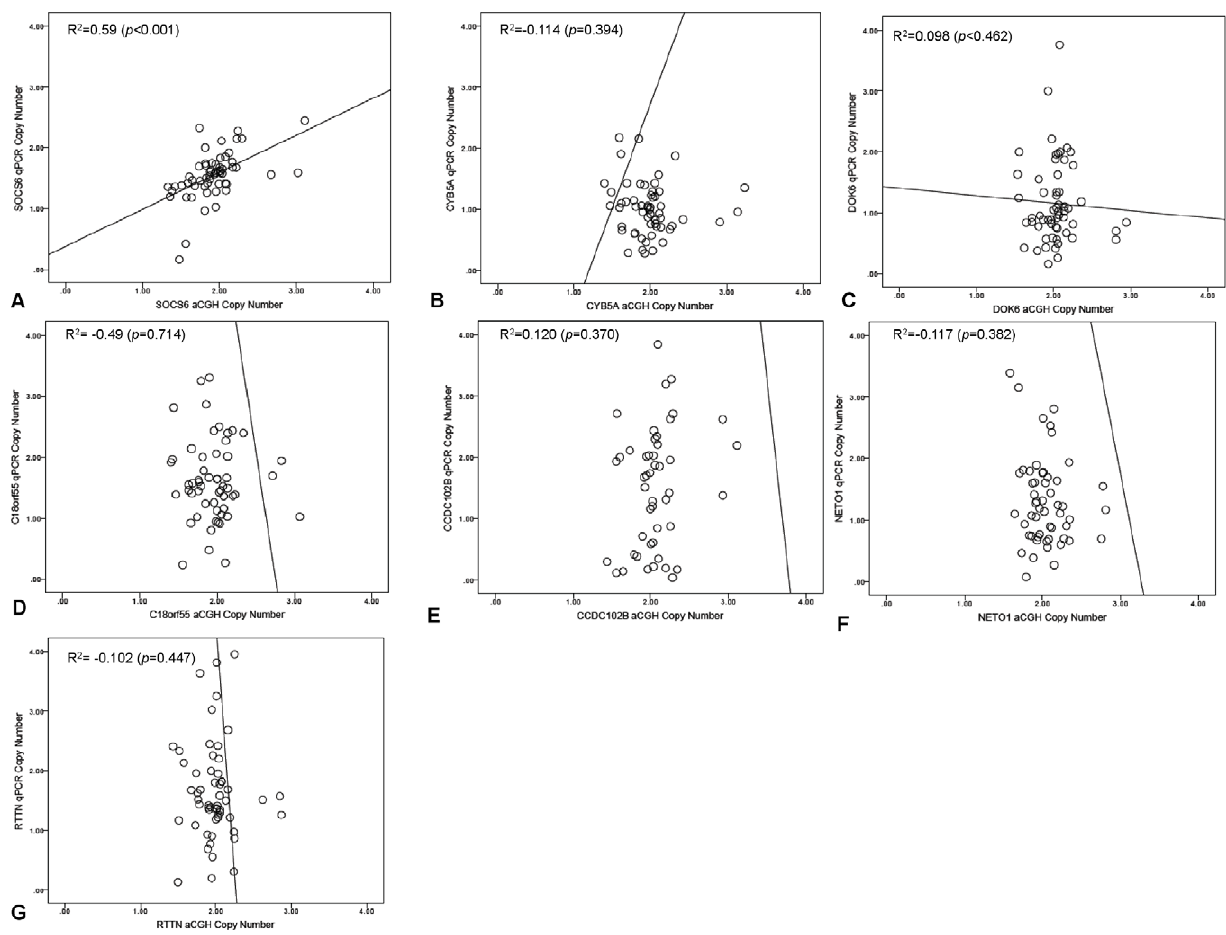
Figure 3. Quantitative PCR (qPCR) validation of array CGH identified candidate genes preferentially lost in SCC recurrence. The Y- axis represents the derived DNA copy number from qPCR normalized to house-keeper genes, b-actin while the X-axis represents the DNA copy number derived from aCGH. Pearson’s correlation coefficient was used to assess for any relationship between the copy number derived from the methods and p values , 0.05 were deemed significant. The aCGH copy number of only SOCS6 (a) was validated by qPCR.